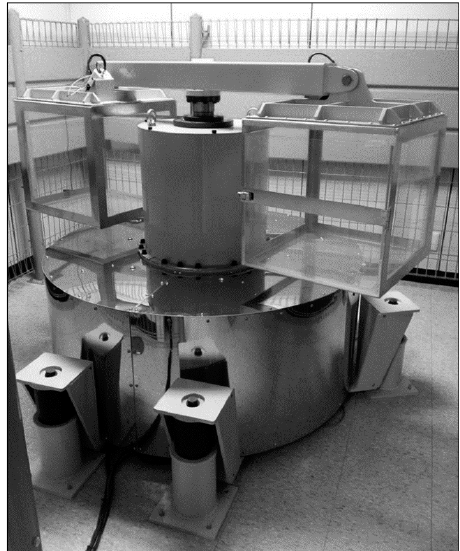
Figure 1. Gravity Simulator for the research on hypergravity [3].